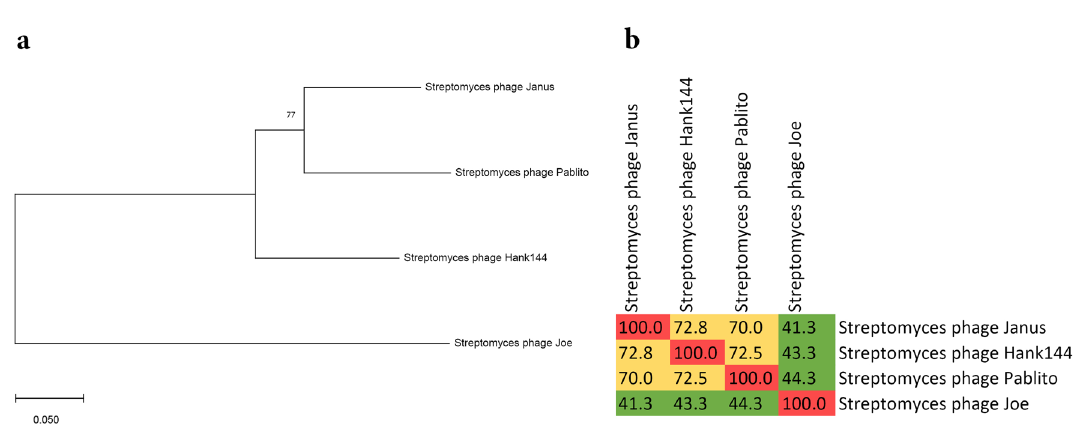
Figure 3. Streptomyces phage Pablito belongs to the subfamily Arquattrovirinae , genus Janusvirus . ( a ) Evolutionary history of phage Pablito based on the major capsid head protein. Total of 100 bootstraps replicates were used to calculate the Maximum-Likelihood tree in MEGA.X. ( b ) Heatmap calculated by VIRIDIC 20 to show pairwise intergenomic distance/relatedness amongst phage genomes. Genomes of Streptomyces phage Janus (NC_054660.1) and Streptomyces phage Hank144 (NC_054661.1) were used to show relatedness, while the genome of Streptomyces phage Joe (NC_054674.1) was used as an